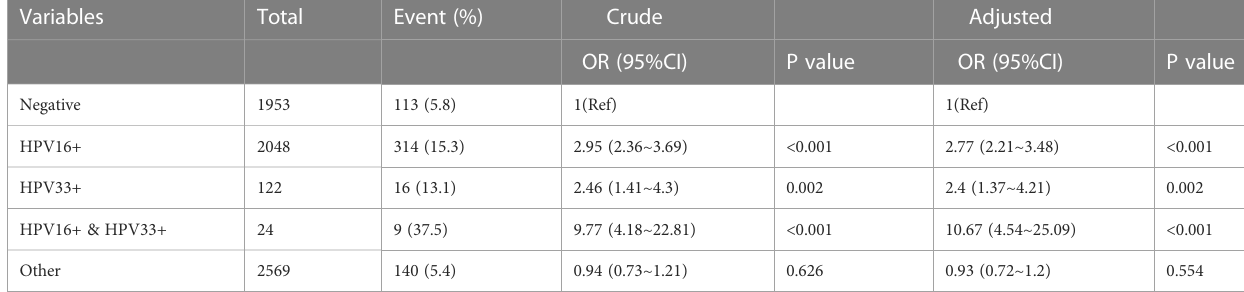
TABLE 2 Univariate and multivariate logistic regression analyses of HPV infection patterns and cervical vascular abnormality. Variables Total Event (%) Crude